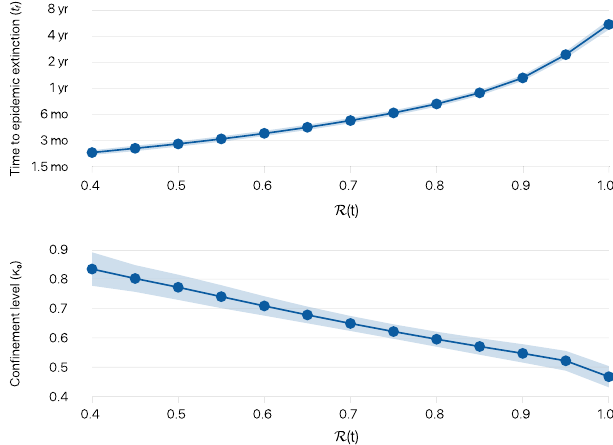
FIG. 4. Relation between the confinement level and time needed for epidemic extinction. Top: Time to epidemic extinction from May 15 as the reproduction number is fixated from this day onward. The reproduction number is kept constant by adjusting the confinement level through time. We define epidemic ex- tinction as a daily incidence of fewer than ten cases. Bottom: Average confinement level necessary to keep the reproduction number constant. At each time step, we correct the confinement level by steps of 0.1% until the effective reproduction number R ð t Þ differs less than 1% from the envisaged